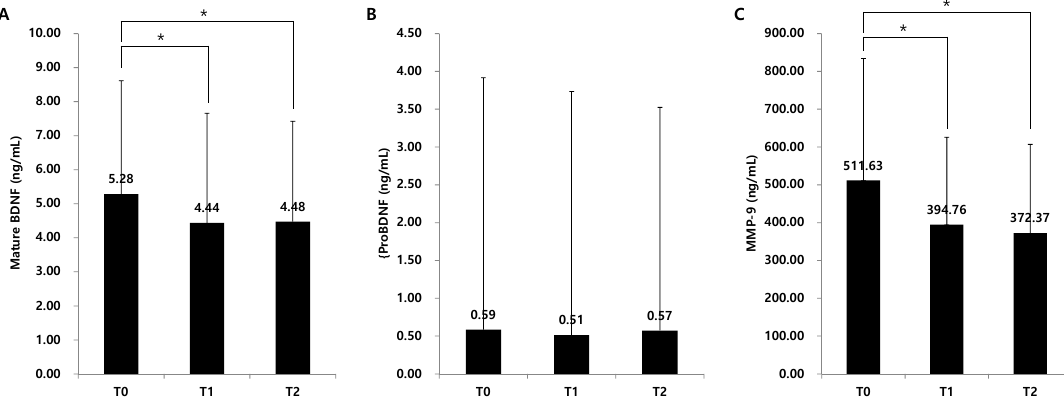
Figure 1. Change of serum BDNF levels. * p < 0.05 comparison between each time point. BDNF, brain-derived neurotrophic factor; MMP-9, matrix metalloproteinase-9. ( A ) Change of mature BDNF, ( B ) Change of proBDNF, ( C ) Change of